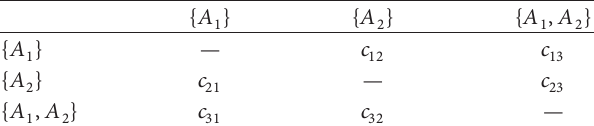
Table 1: The complete pairwise comparison